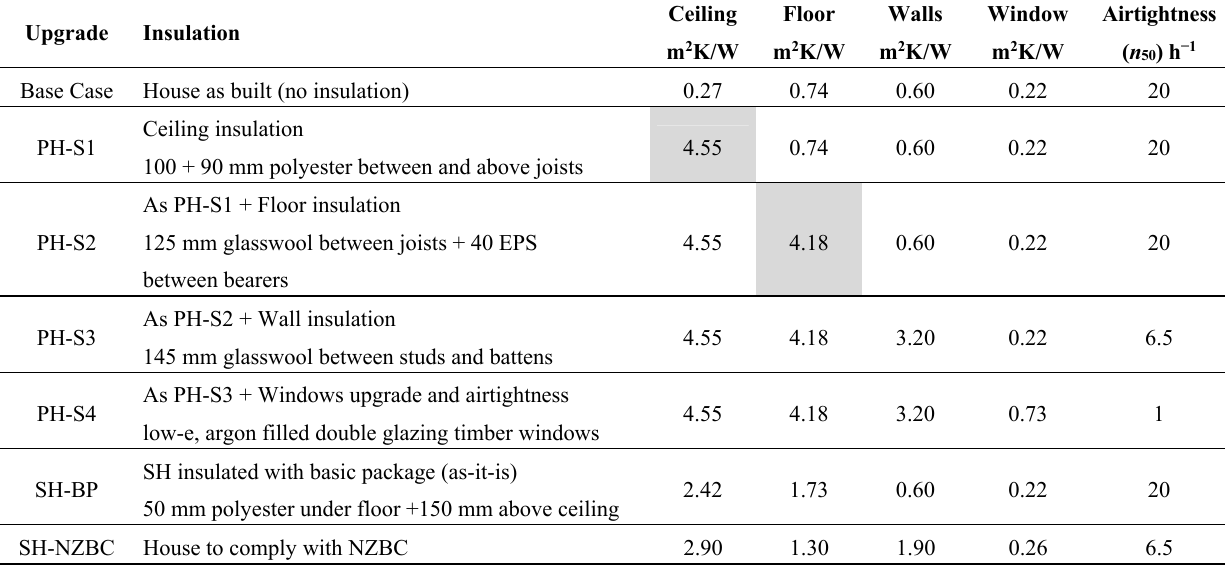
Table 1. Upgrade levels, including a summary of R -values (m 2 K/W) used for each element of the building fabric for PHPP